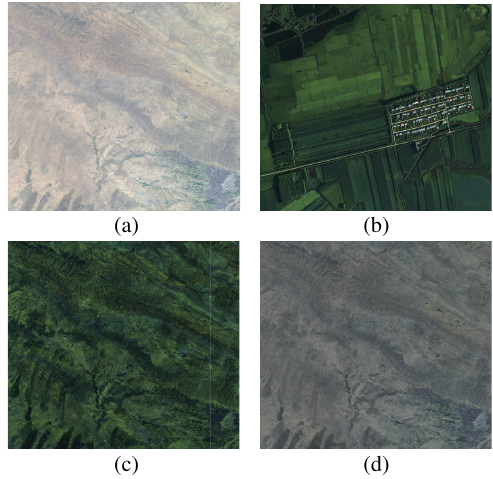
Figure 3. A comparative illustration of our improved color transferring equation: (a) the original image with a little over exposure; (b) the reference image; (c) the resulting image via Eq. (1); (d) the resulting image via Eq. (2) with the default weight